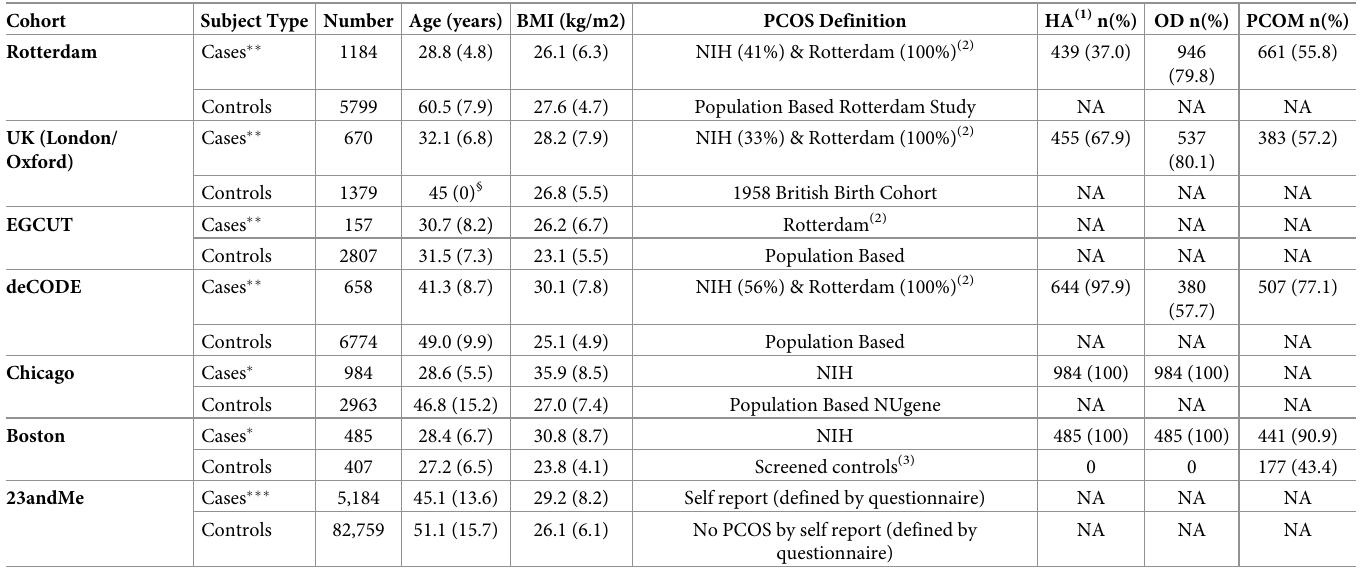
Table 1. Characteristics of PCOS cases and controls from each cohort included in the meta-analysis.